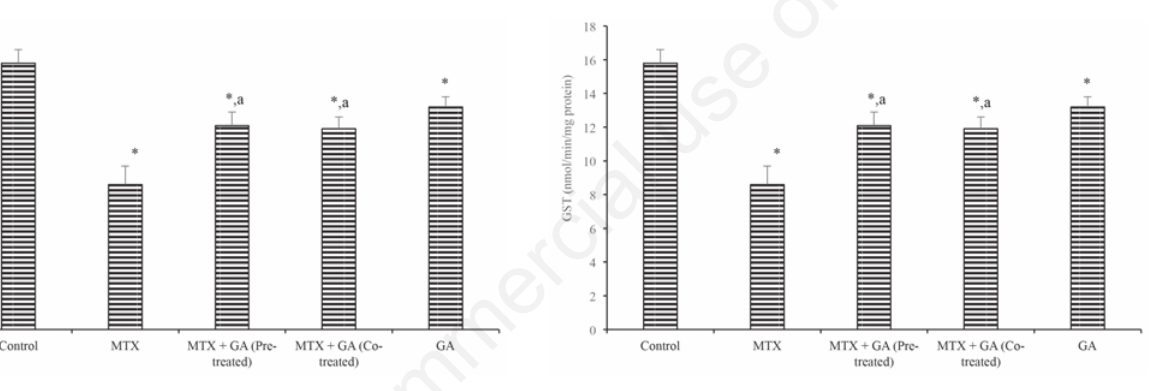
Figure 4. Ameliorative effect of gallic acid pre-treatment and co- treatment on methotrexate-induced reduction in hepatic glu- tathione (GSH) level in rats. Data are expressed as mean ± S.D for six rats in each group. *Significantly different from the con- trol (P<0.05); a significantly different from the methotrexate group (P<0.05).